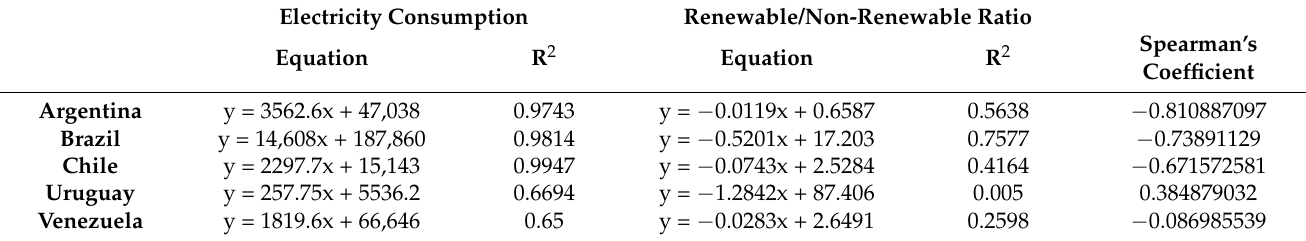
Table 7. Correlation between electricity consumption and renewable/non-renewable ratio using Spearman’s